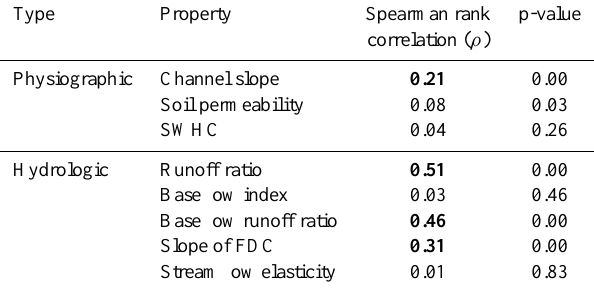
Table 1. Correlation of catchment properties with Nash-Sutcliffe (NS) efficiency of simulation. Bold values indicate statistically sig- nificant value ( p <